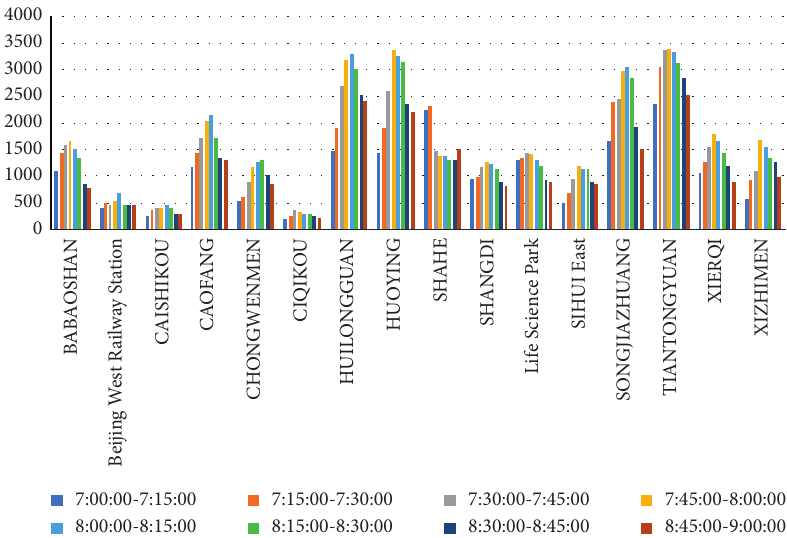
Figure 1: Inbound demand of stations during morning rush